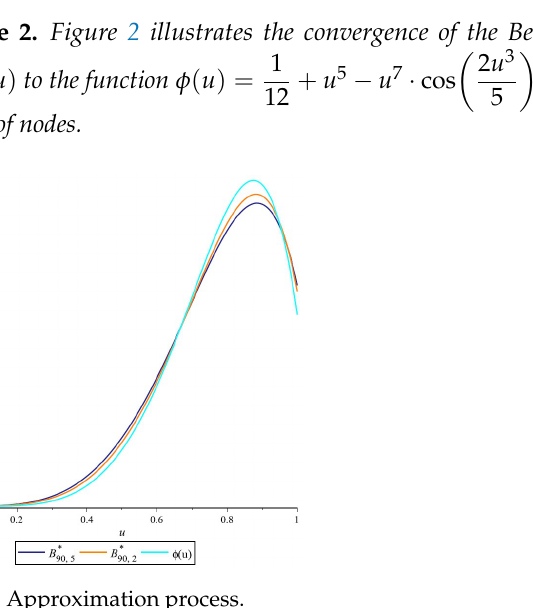
Figure 1. Approximation process.